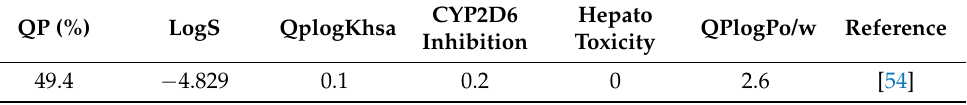
Table 1. ADMET results of ginsenoside Rh1 with pharmacokinetic properties. QP (%) LogS QplogKhsa